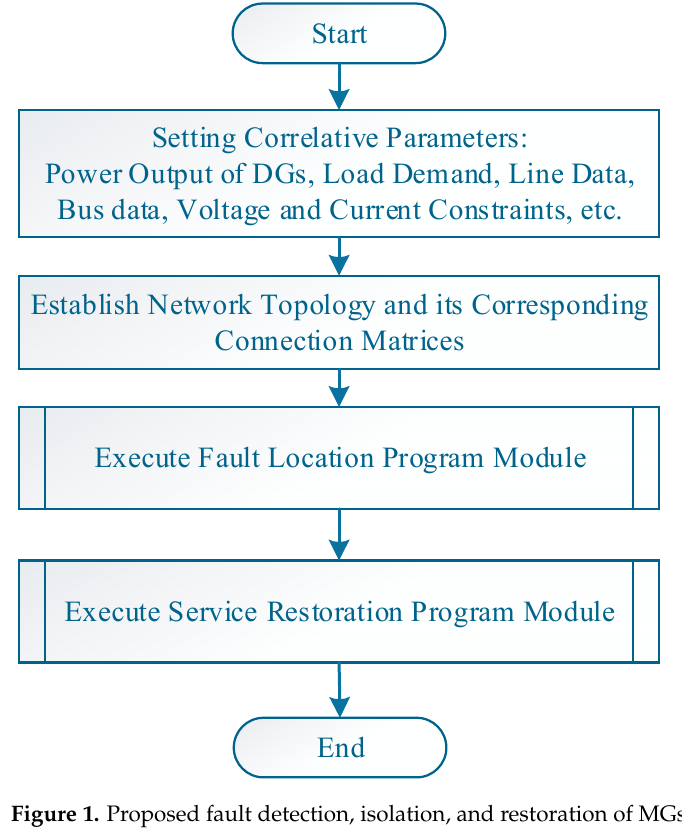
Figure 1. Proposed fault detection, isolation, and restoration of